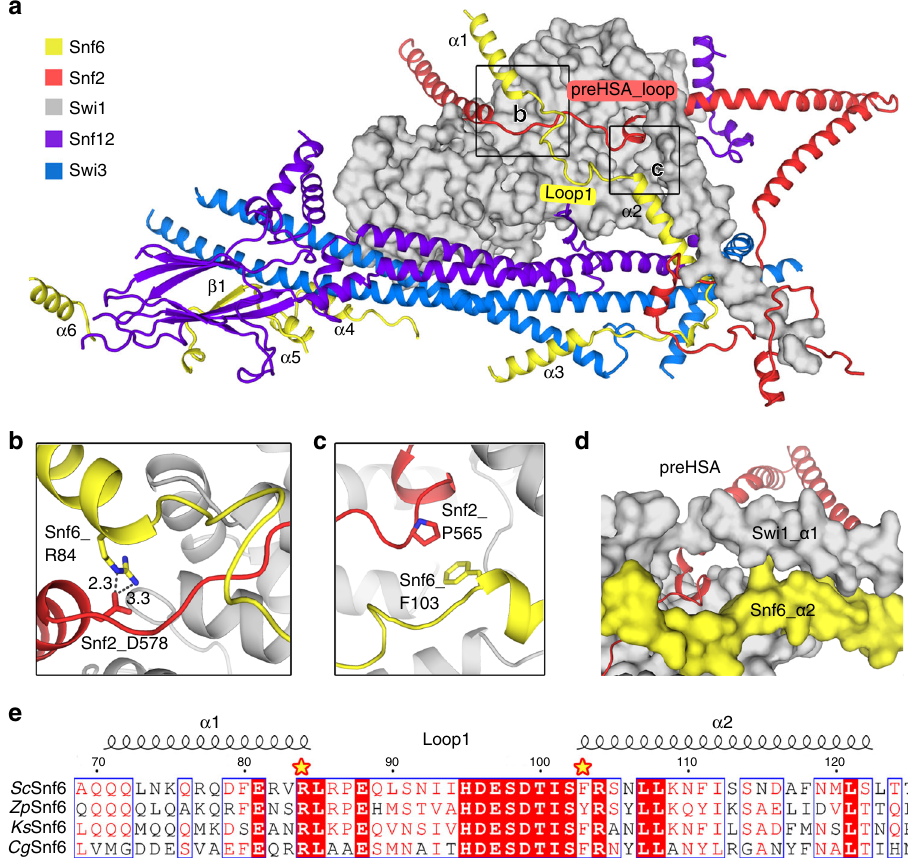
Fig. 3 Snf6 locks the preHSA loop above the base module. a Shown here is the conformation of Snf6 and the surrounding proteins. Snf6 adopts an extended conformation and displays an “ L ” shape, with α 1-2 and loop 1 (residues 85 – 102) stretching along the surface of Swi1 and the following sequence ( α 3-6 and β 1) turned approximately 90° to adhere to the periphery of the CC domain. The protein elements are color coded and tabulated on the left. b , c Close-up views of the interactions between Snf6 and Snf2. d Snf6_N α 2 and Swi1_ α 1 form a “ clamp-like ” shape. e Sequence alignment of Snf6_loop 1 from different yeast species. Sc Saccharomyces cerevisiae , Zp Zygosaccharomyces parabailii, Ks Kazachstania saulgeensis , Cg Candida glabrata complex organization and will shed light on investigation of more complicated SWI/SNF complexes from different species.